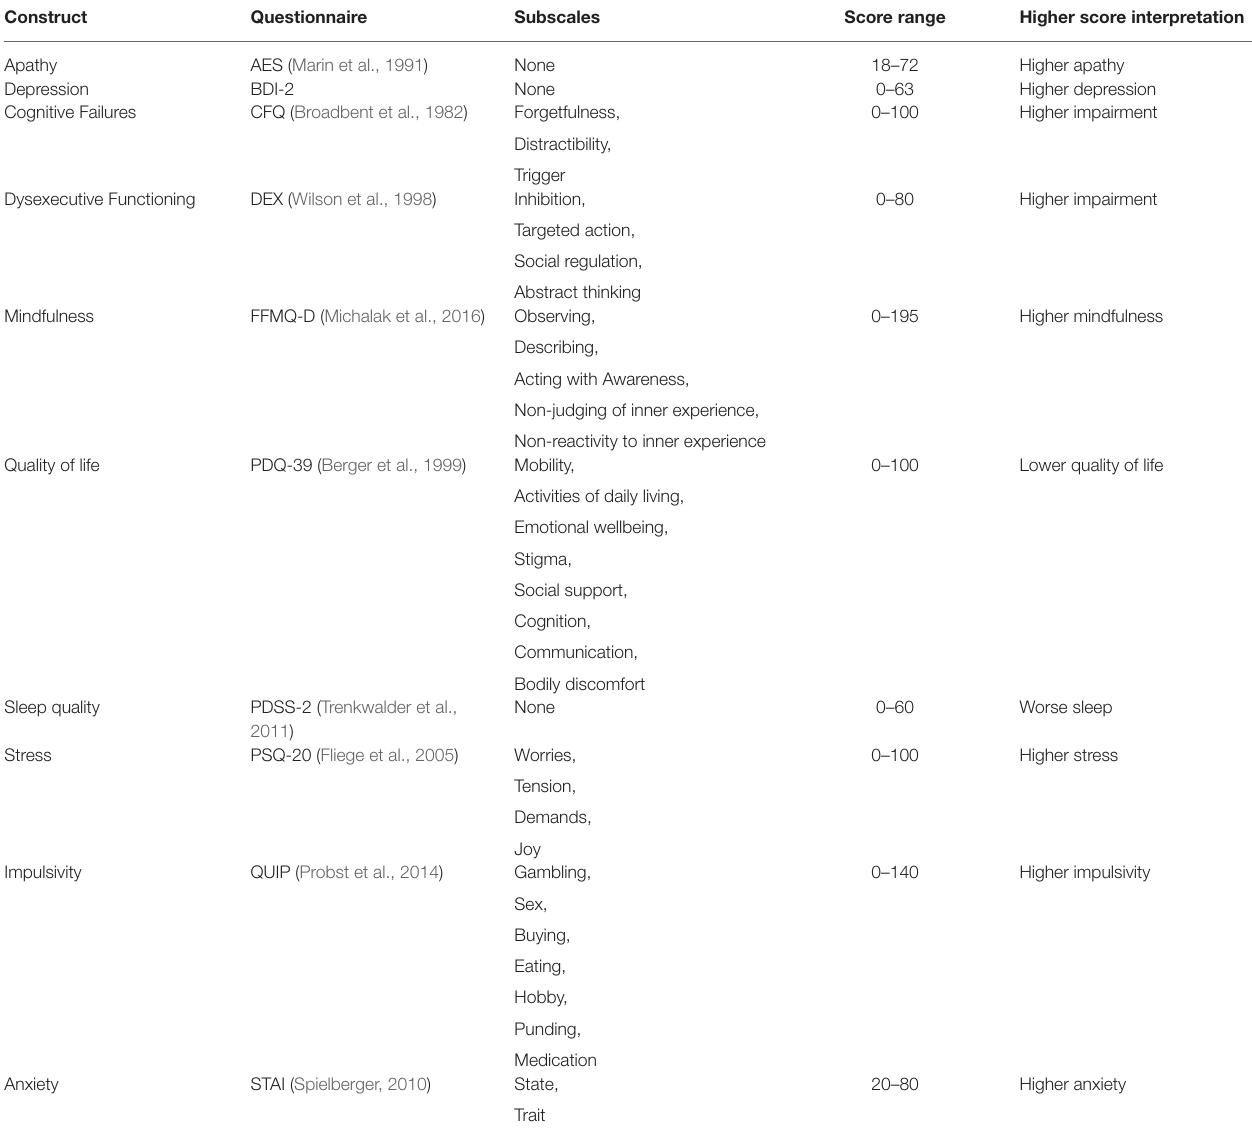
TABLE 2 | Overview of questionnaire subscales, score range, and score